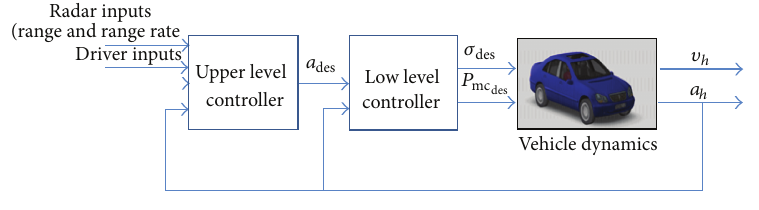
Figure 4: Adaptive cruise control system.